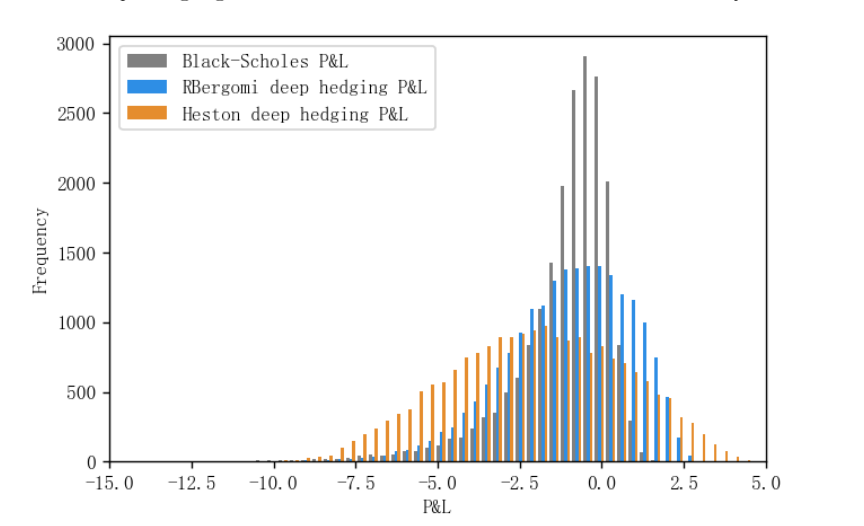
Figure 12. P&L distribution for the FTSE options data with maturities from 21 January 2022 to 15 December